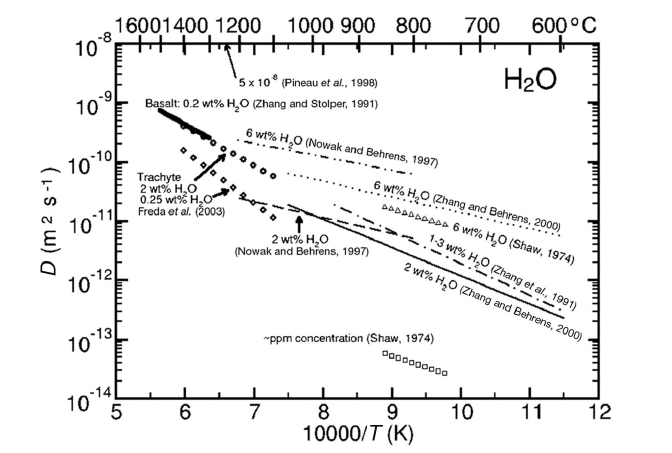
Fig. 1. Diffusion of water in magmatic silicate melts. Unless otherwise noted the measurements are made in melts of either rhyolitic or haplogranitic composition. Where calculations are pressure dependent a pressure of 200 MPa has been